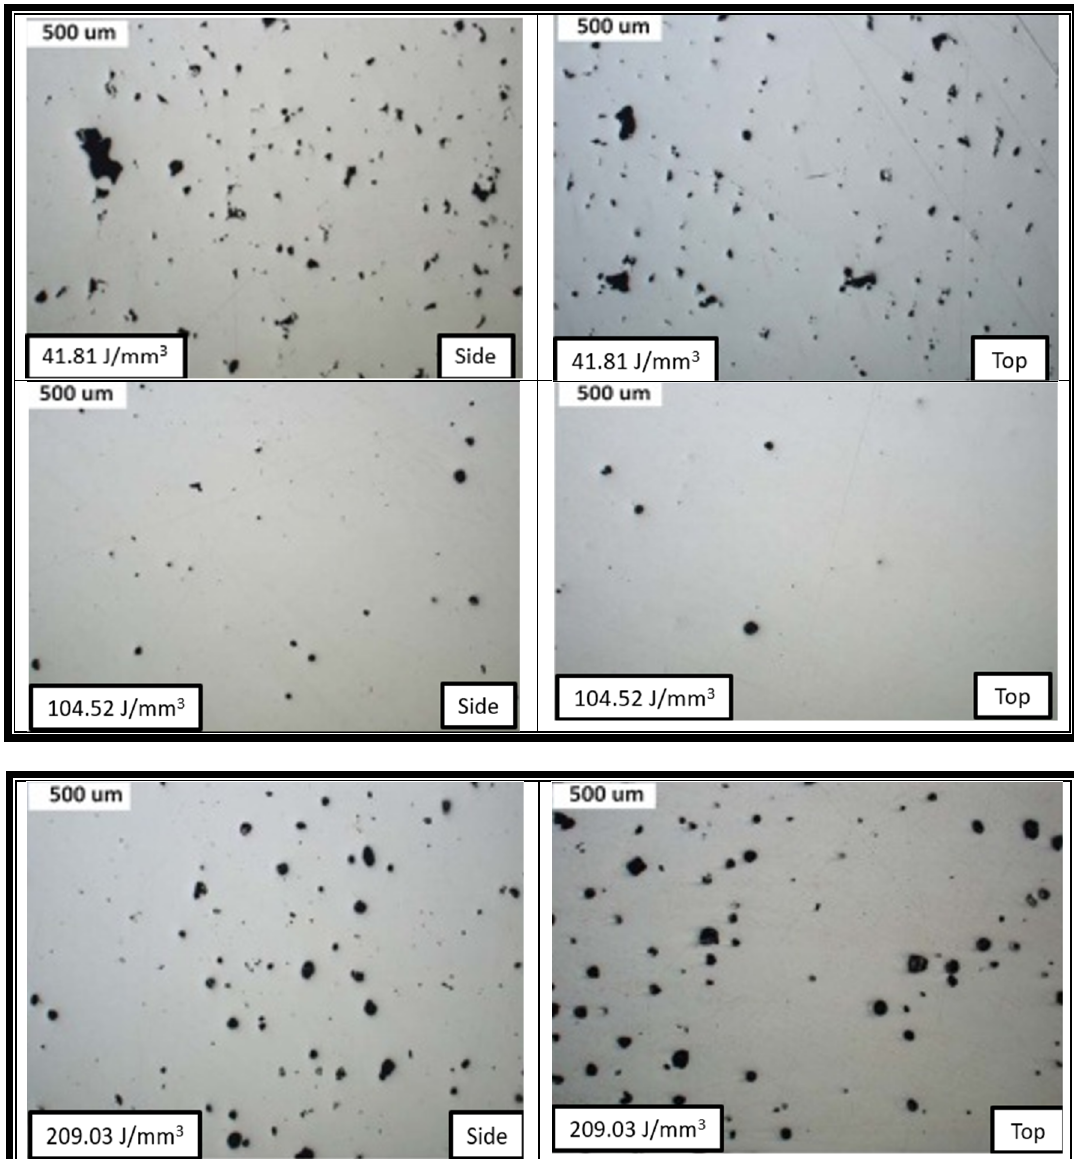
Figure 10. Porosity at different energy densities of 41.81, 104.52, and 209.03 J/mm 3 .